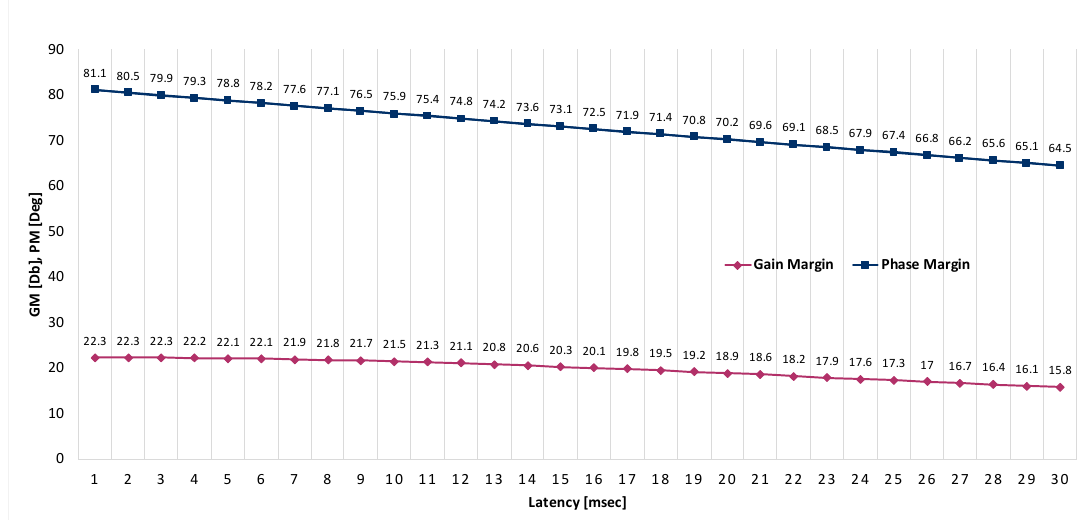
Figure 21. Gain and phase margins as indexes of control stability.